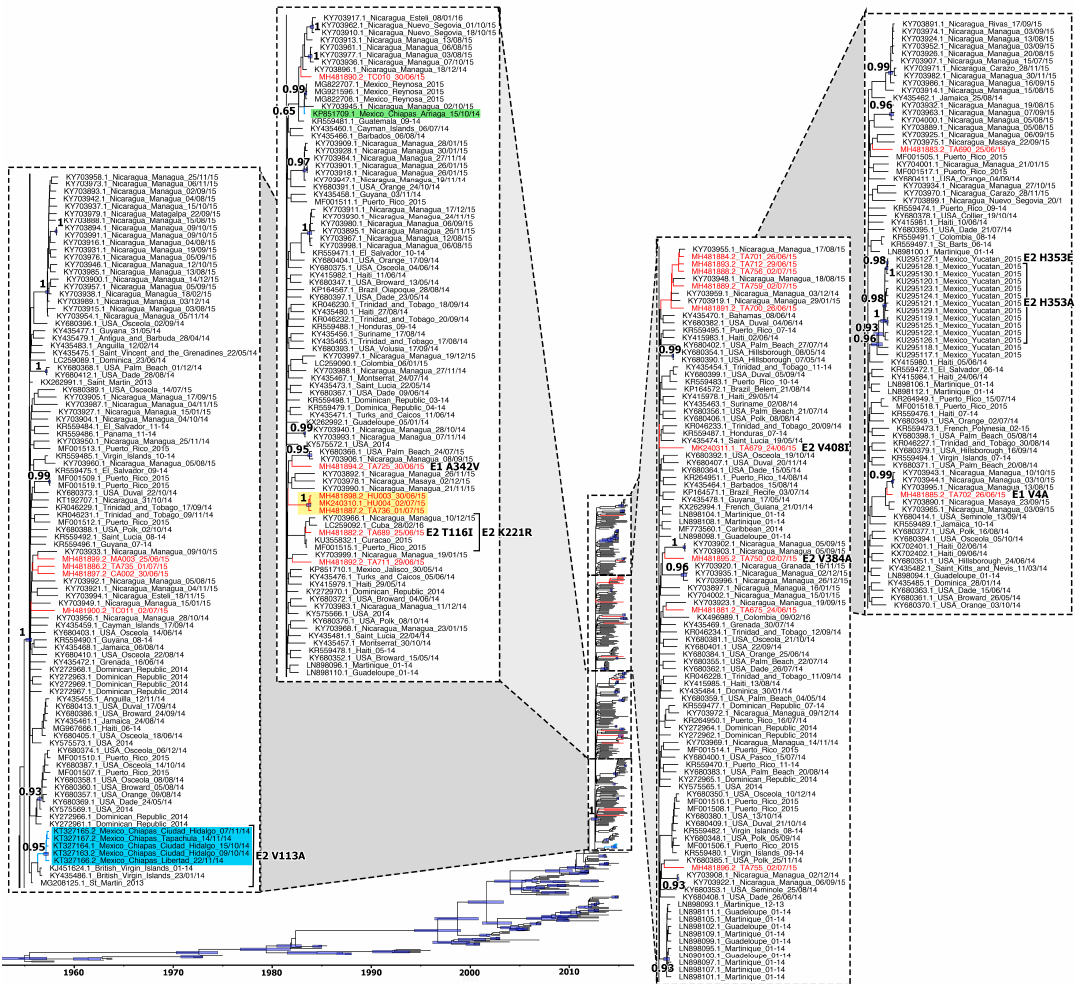
Figure 1. Maximum clade credibility phylogeny of Chikungunya virus (CHIKV) Asian genotype. Taxon labels include accession number, isolation place, and year. The Caribbean outbreak clade was split in four parts and magnified. Branch lengths are scaled to the sampling and divergence times. Node heights with a posterior probability of >90 have thick blue horizontal node bars that represent 95% higher posterior density (HPD) values. Posterior probabilities are indicated as bold numbers. Relevant amino acid changes are indicated at the tips. The sequences obtained in this study are marked in red. Sequences from southern Chiapas in 2014 are highlighted in blue; while the sequence from northern Chiapas in 2014 is highlighted in green. The Huixtla clade is highlighted in yellow.